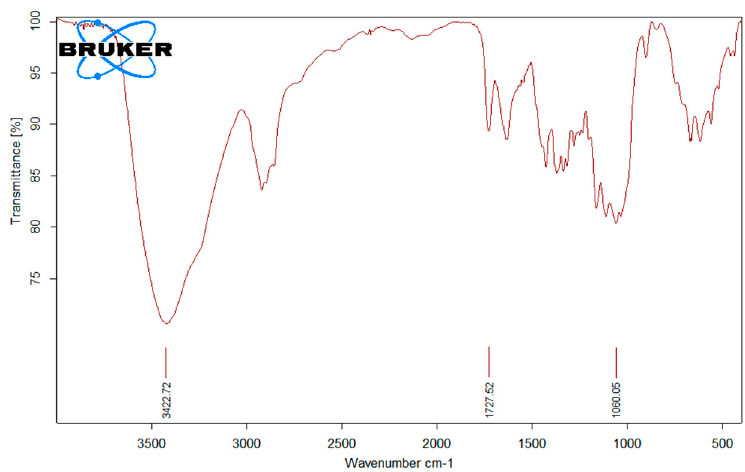
Figure 6. BNC-GMA MS = 0.12 FT–IR spectrum: cellulose profile plus GMA appendages.